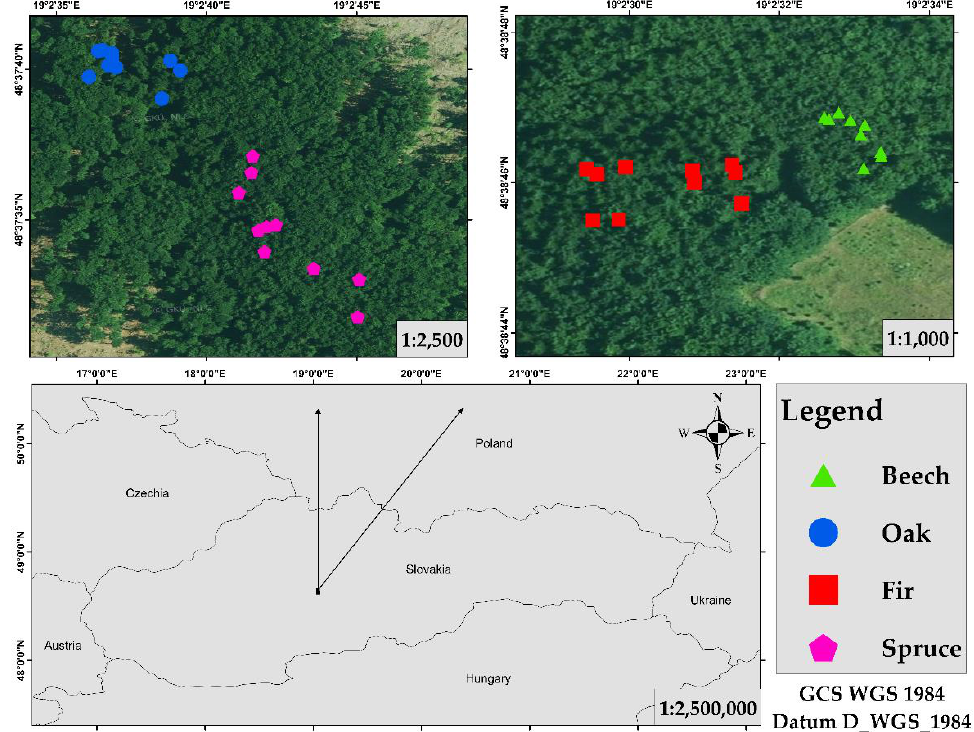
Figure 1. Overview of the trees’ positions within the forest stands, and their positions within the Slovak republic are shown below.